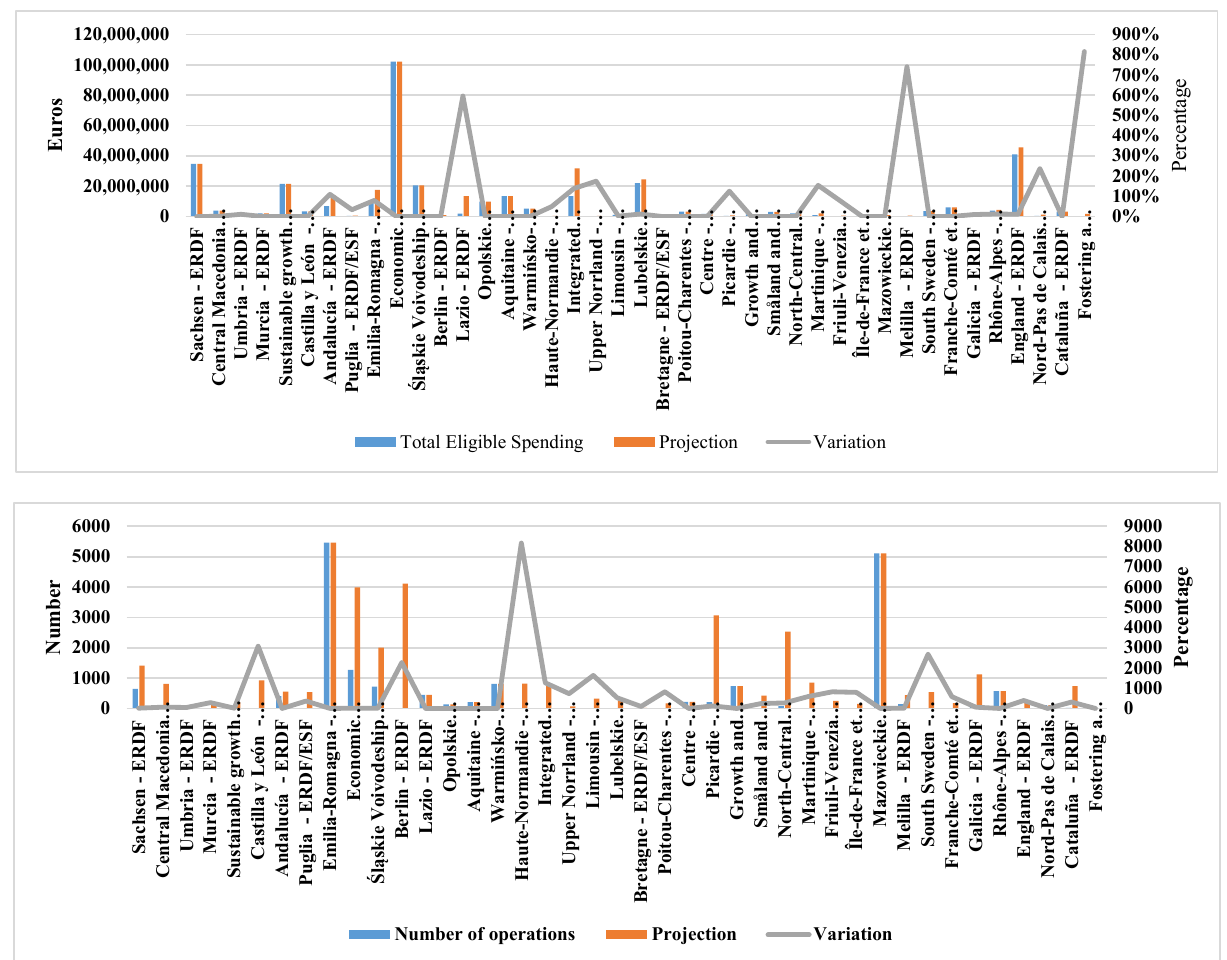
Figure 4. Potential output improvements for every inefficient OP.